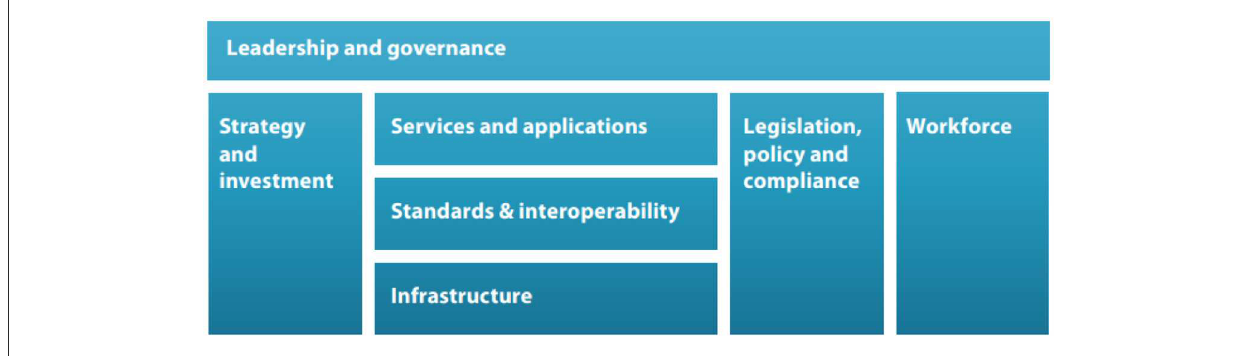
FIGURE1 WHO-ITU eHealth strategy building blocks. Source: World Health Organization (WHO), International Telecommunication Union (ITU)